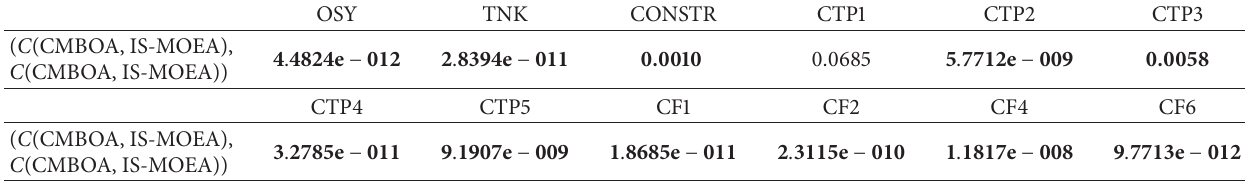
Table 3: Wilcoxon rank-sum test on C value of CMBOA and IS-MOEA.